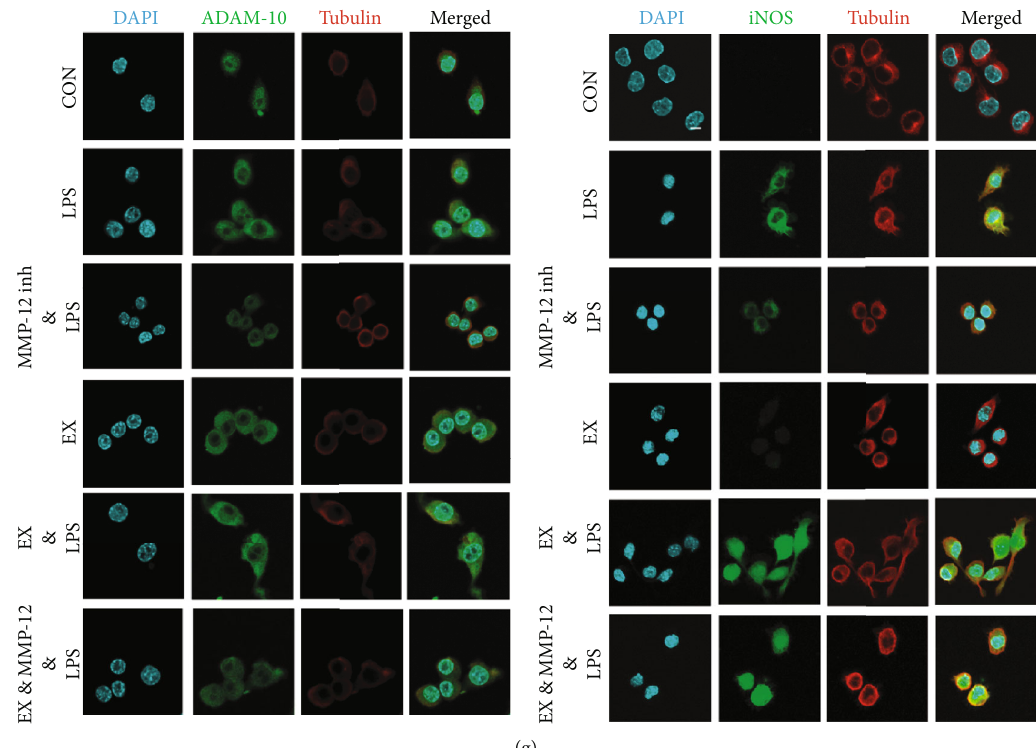
Figure 4: Overexpressing A disintegrin and metalloprotease 10 (EX ADAM-10) increases lipopolysaccharide-promoted proliferation- (LPS- ) induced macrophage activation via matrix metalloproteinase 12 (MMP-12) upregulation. (a) Real-time qualitative PRC (RT-qPCR) analysis of the e ff ect of EX ADAM-10 in RAW264.7 cells. Each dot represents a readout. (b) Comparison of the gene transcription levels of interfered ADAM (sh ADAM-10) and EX ADAM-10 in RAW264.7 cells by RT-qPCR. Each dot represents a readout. (c) RT-qPCR analysis of the e ff ect of LPS on gene transcription in EX ADAM-10 RAW246.7 cells. Each dot represents a readout. (d) The e ff ect of LPS and MMP-12 inhibitors on EX ADAM-10 RAW246.7 cell viability. Each group contained six samples. (e) Enzyme-linked immunosorbent assay (ELISA) analysis of ADAM-10 secretion in response to LPS and MMP-12 inhibitors in EX ADAM-10 RAW246.7 cells. Each group contained six samples. (f) Flow cytometric analysis showed that EX ADAM-10 upregulated MMP-12 expression. (g) Immuno fl uorescence of EX ADAM-10 RAW246.7 cells, followed by treatment with LPS and MMP-12 inhibitors. Scale bar = 10 μ m . Data are expressed as the mean ± SD . ∗ P < 0 : 05 and ∗∗ P < 0 : 01 compared with the CON group; # P < 0 : 05 and ## P < 0 : 01 compared with the LPS